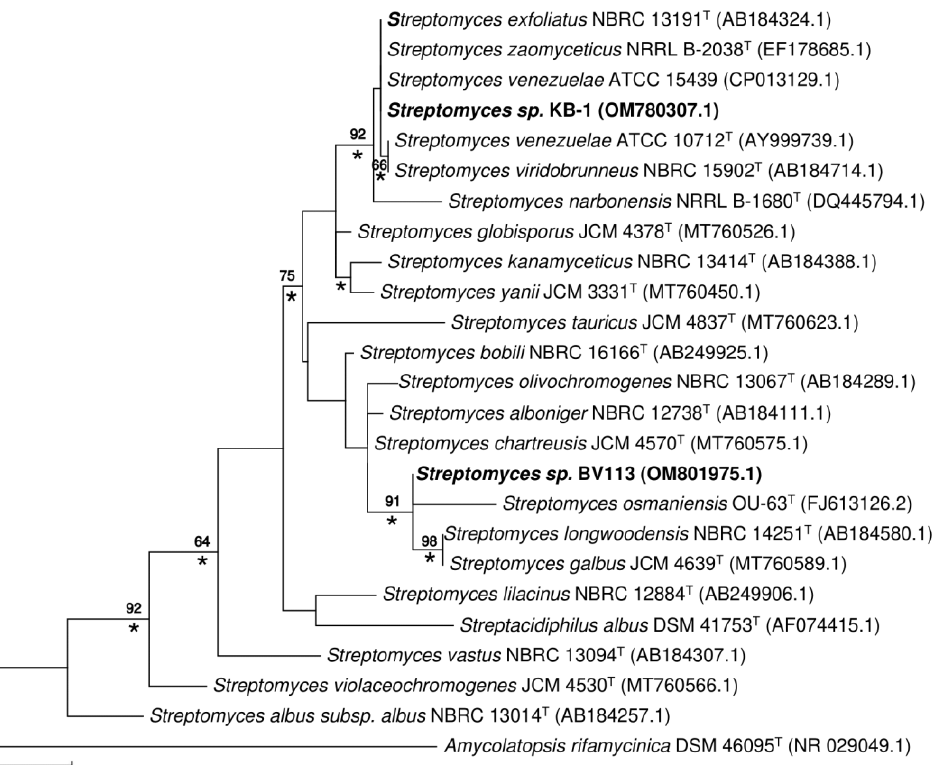
Figure 6. Maximum Likelihood phylogenetic tree based on the Tamura – Nei model, showing the relationship between isolated strains, KB-1 and BV113, and representative members of the genus Streptomyces (based on 1147 unambiguously aligned nucleotides of 16S rRNA gene sequence). Num- bers at nodes are bootstrap support percentages based on 1000 sampled datasets; only values above 60% are shown. Asterisks (*) indicate the branches that were also found in the Neighbor-Joining tree. Bar, 0.01 substitutions per nucleotide position.